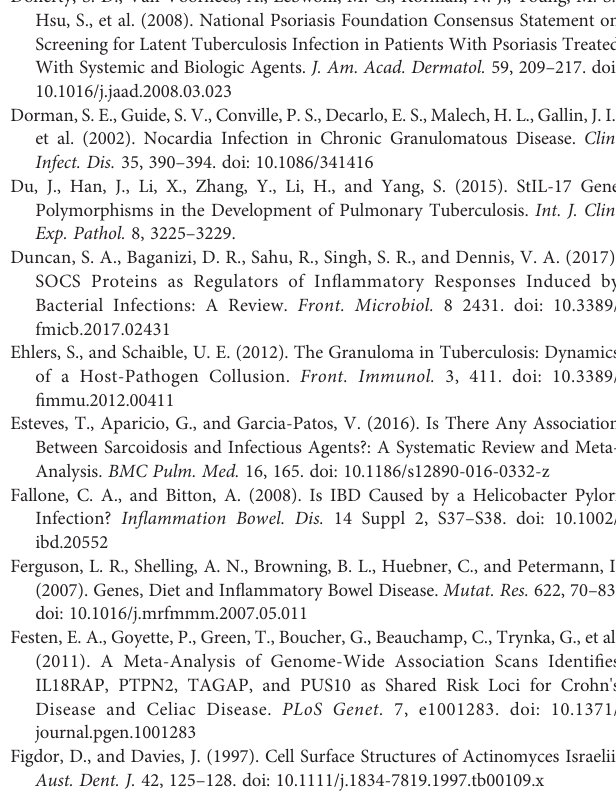
Figdor, D., and Davies, J. (1997). Cell Surface Structures of Actinomyces Israelii. Aust. Dent. J. 42, 125 – 128. doi: